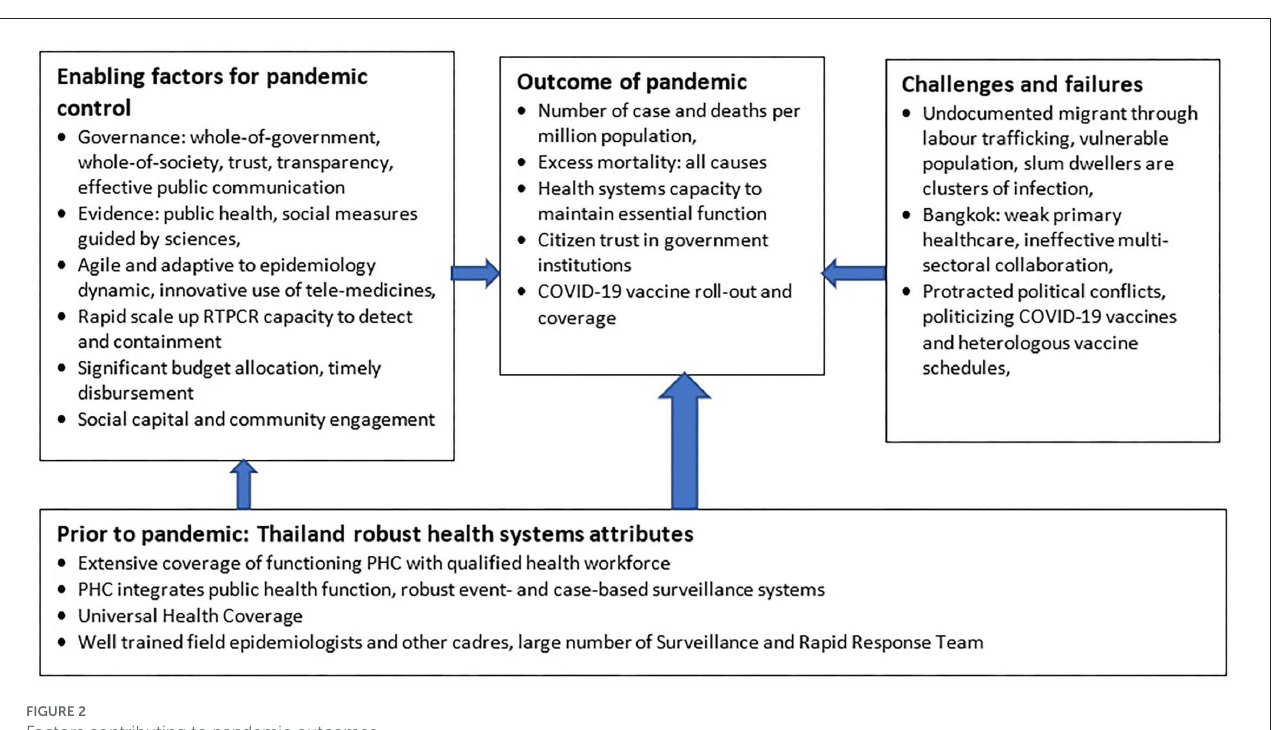
FIGURE2 Factors contributing to pandemic